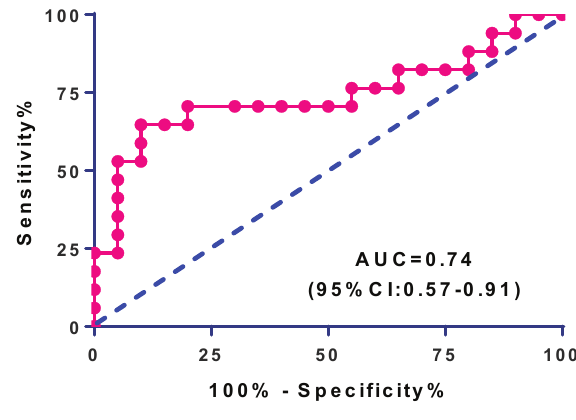
Figure 3: The ROC curve for serum neopterin in differentiation of MODS from